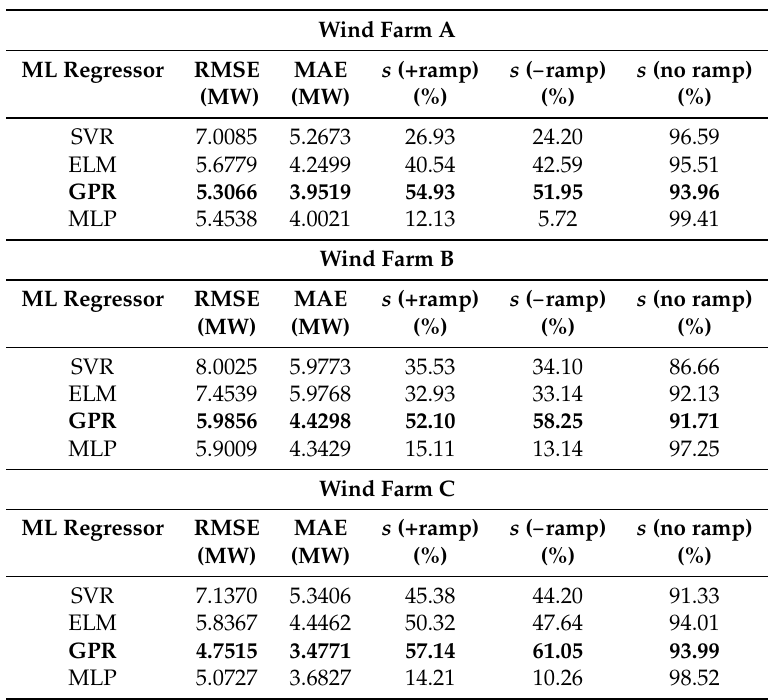
Table 4. Results (in terms of RMSE, MAE and sensitivity) corresponding to the estimation of the ramp function S 1 t ( Equation (1) ) obtained when using the proposed approach, as a function of the ML regressors explored (SVR, ELM, GPR and MLP), in the tree study cases: the wind farms “A”, “B” and “C”, whose locations have been represented in Figure